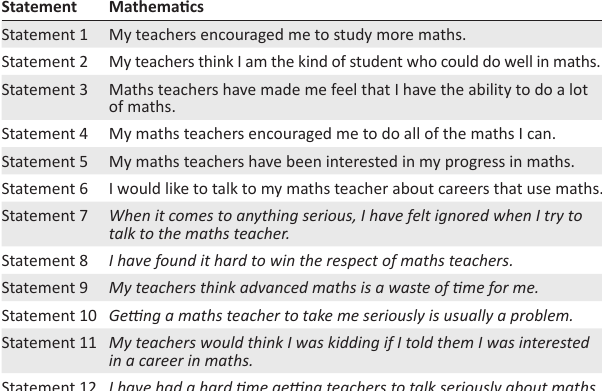
TABLE 2: Teacher’s encouragement and support subscale.